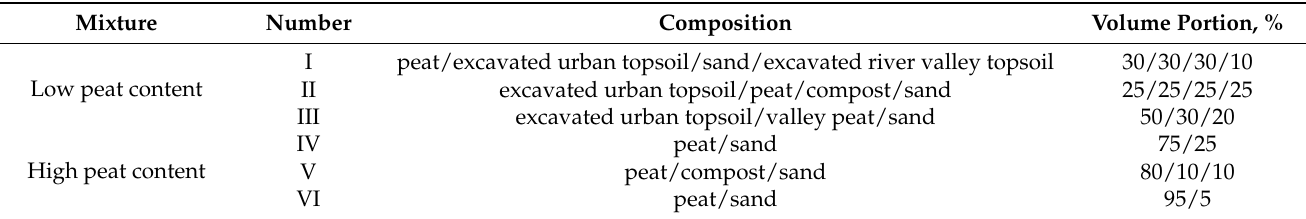
Table 2. The composition of the investigated commercial